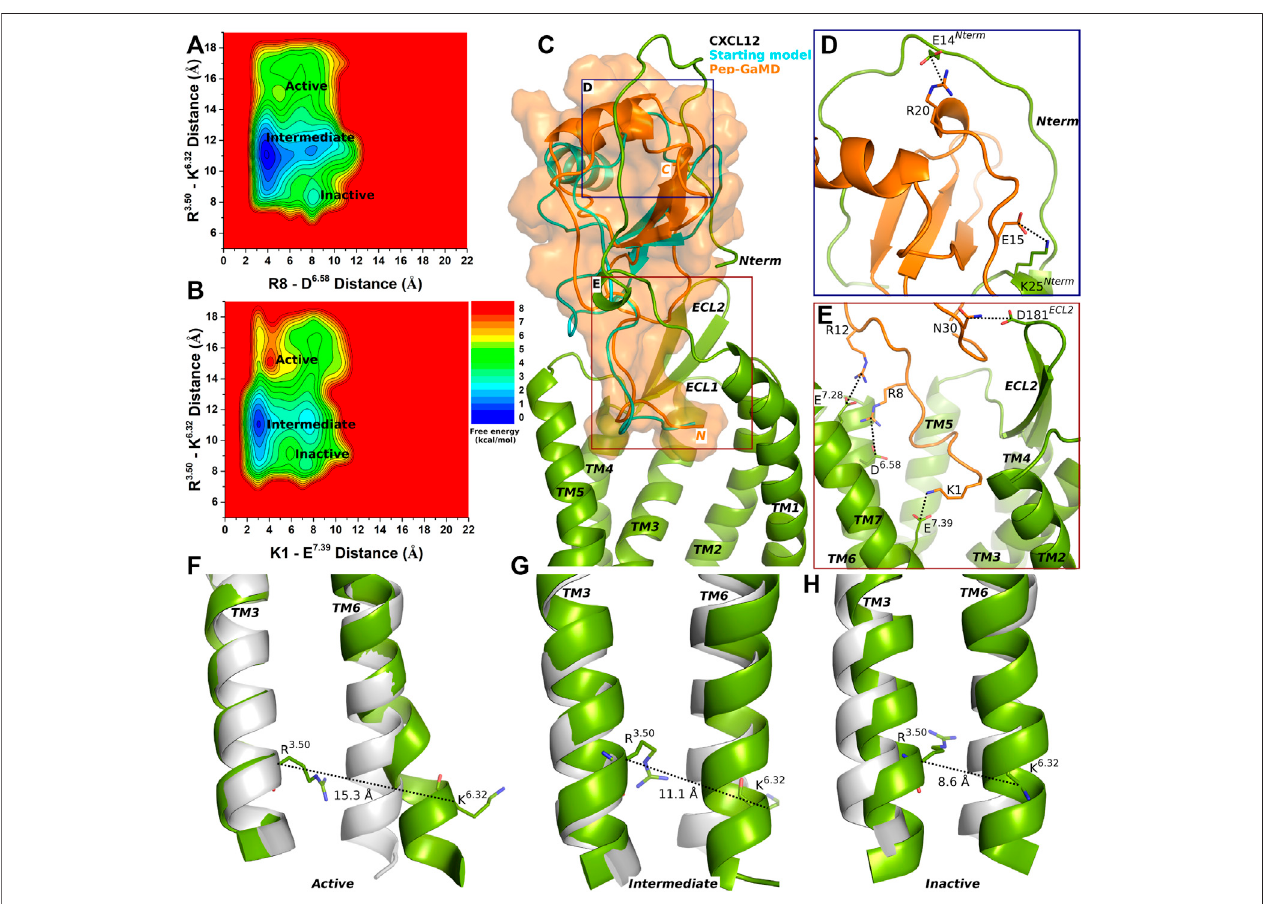
FIGURE 1 | Endogenous agonist (CXCL12) bound CXCR4 sampled three Active, Intermediate and Inactive low-energy states. (A – B) Free energy pro fi les of CXCR4-CXCL12interactionscalculatedregardingthedistancebetweentheC α atomsofR 3.50 andK 6.32 and (A) distancebetweenchargecentersofpeptideresidueR8 (the CZ atom) and receptor residue D 6.58 (the CG atom), (B) distance between charge centers of peptide residue K1 (the NZ atom) and receptor residue E 7.39 (the CD atom). (C) Comparison of the top-ranked structural cluster of the endogenous agonist (CXCL12) obtained from Pep-GaMD simulations (orange cartoon) with the starting computational model (cyan cartoon). (D – E) Important residue interactions between the peptide (orangesticks) and receptor (green sticks) observed in the Pep- GaMD simulations. (F – H) The TM3-TM6 distance between the C α atoms of R 3.50 and K 6.32 as observed in the (F) Active, (G) Intermediate and (H) Inactive